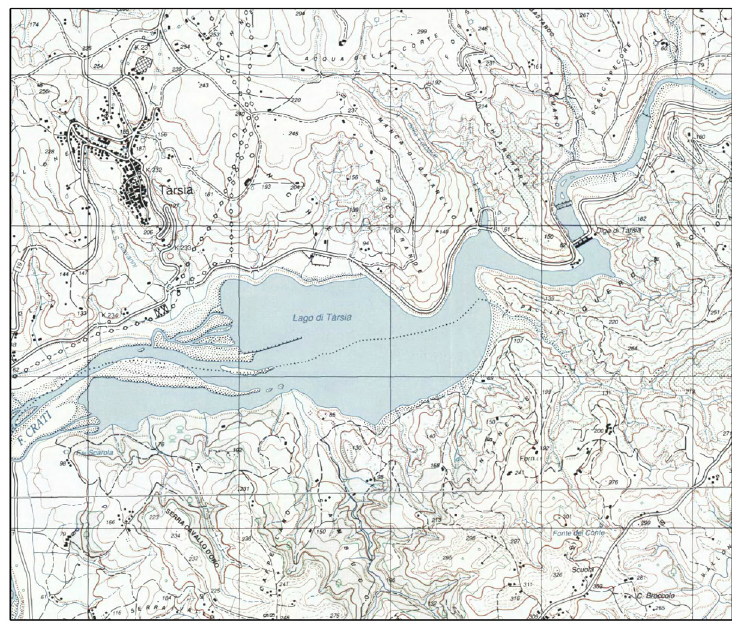
Figure 1. Topographic map of Tarsia Lake